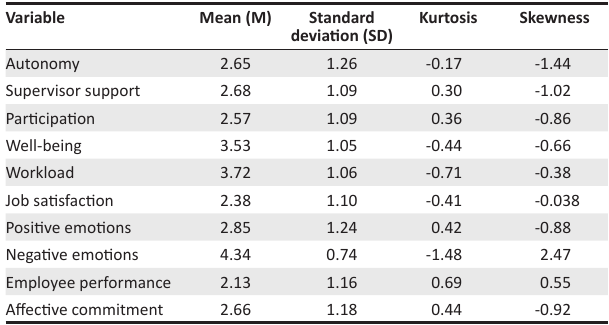
TABLE 2: Descriptive statistics, Cronbach’s alphas and average variances